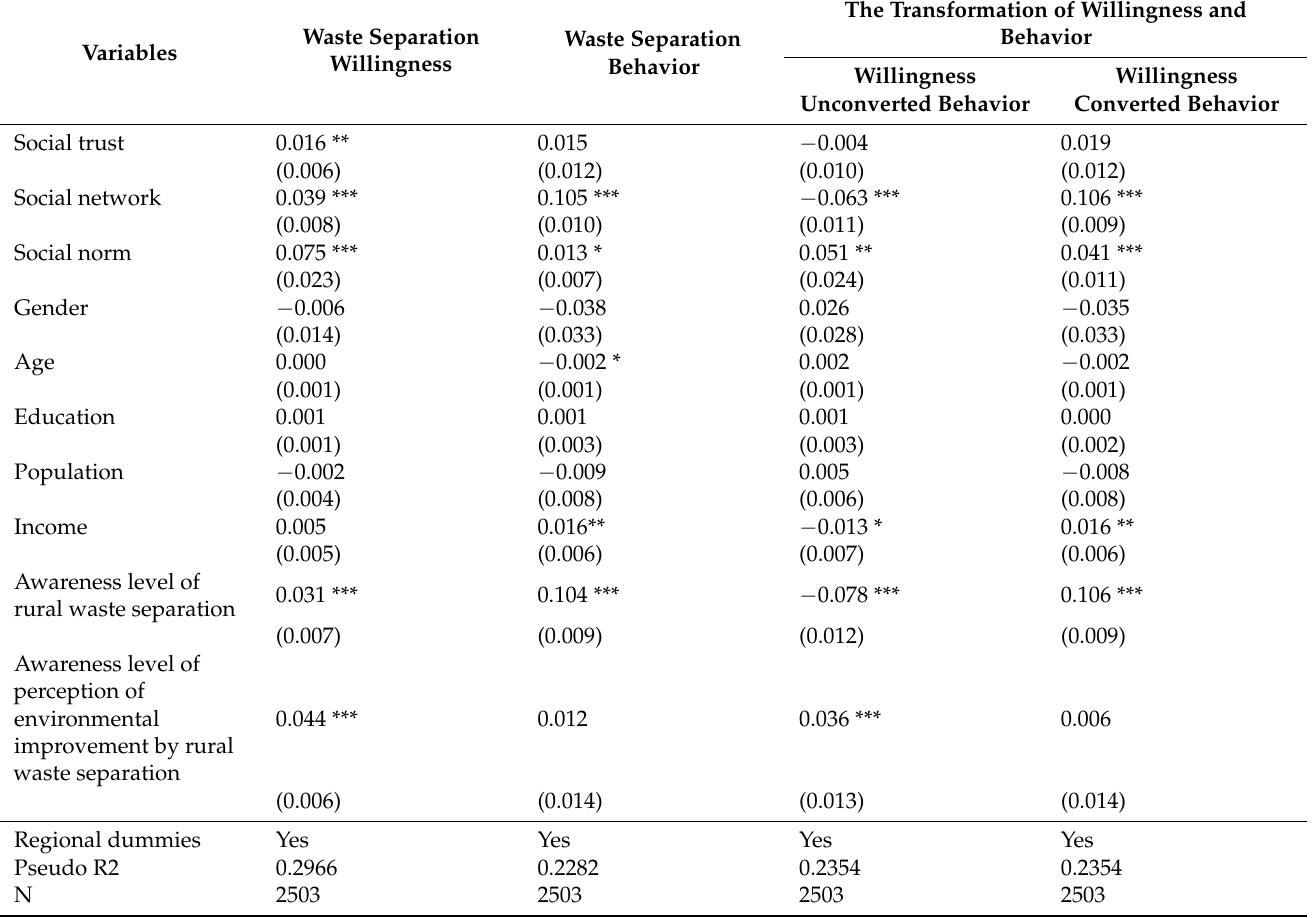
Table 4. Effect of social capital on the willingness and behavior of farm households to separate